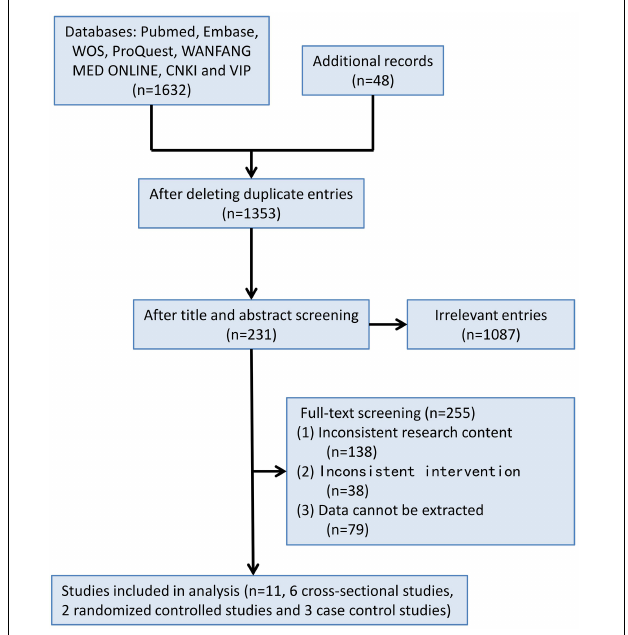
FIGURE 1 | Flow diagram showing the study selection